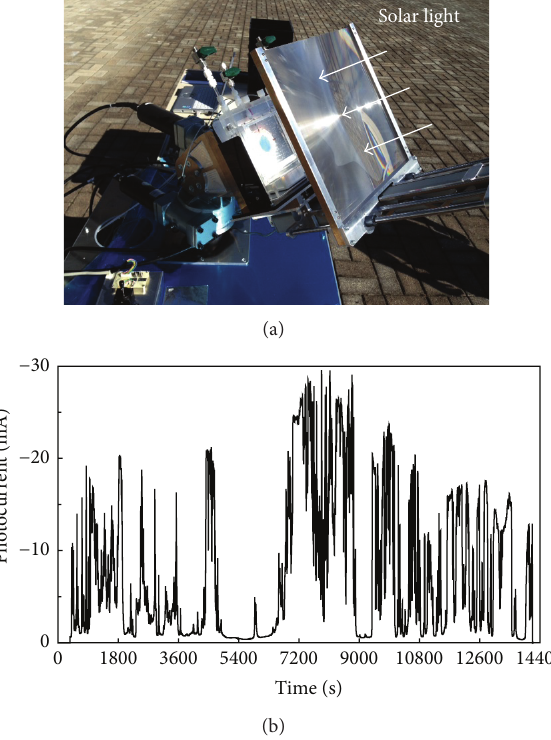
Figure 4: (a) Picture of outdoor experiment. (b) Time course of photocurrent during the